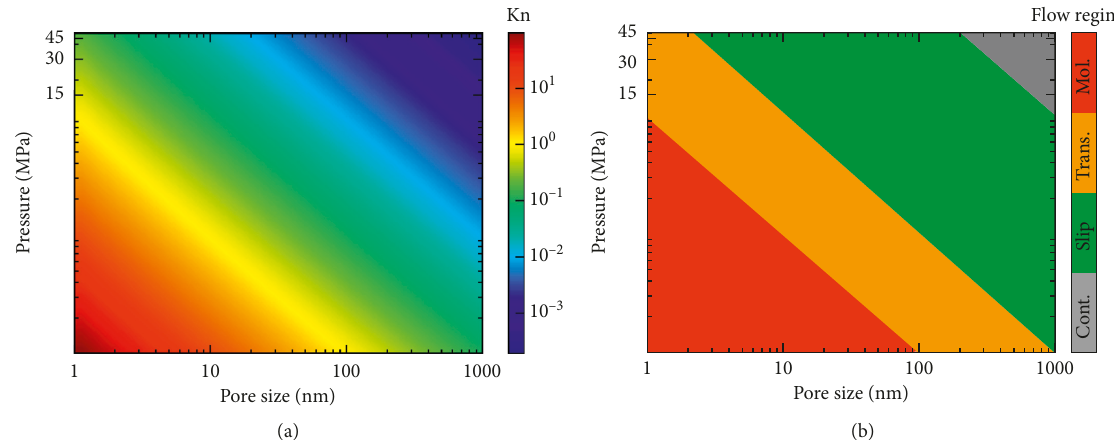
Figure 1: (a) Variation of Kn values as a function of channel height and pressure, and (b) graphical representation of corresponding gas flow regimes. Here, Cont., Slip, Trans., and Mol. represent continuum flow regime, slip flow regime, transition flow regime, and molecular flow regime,